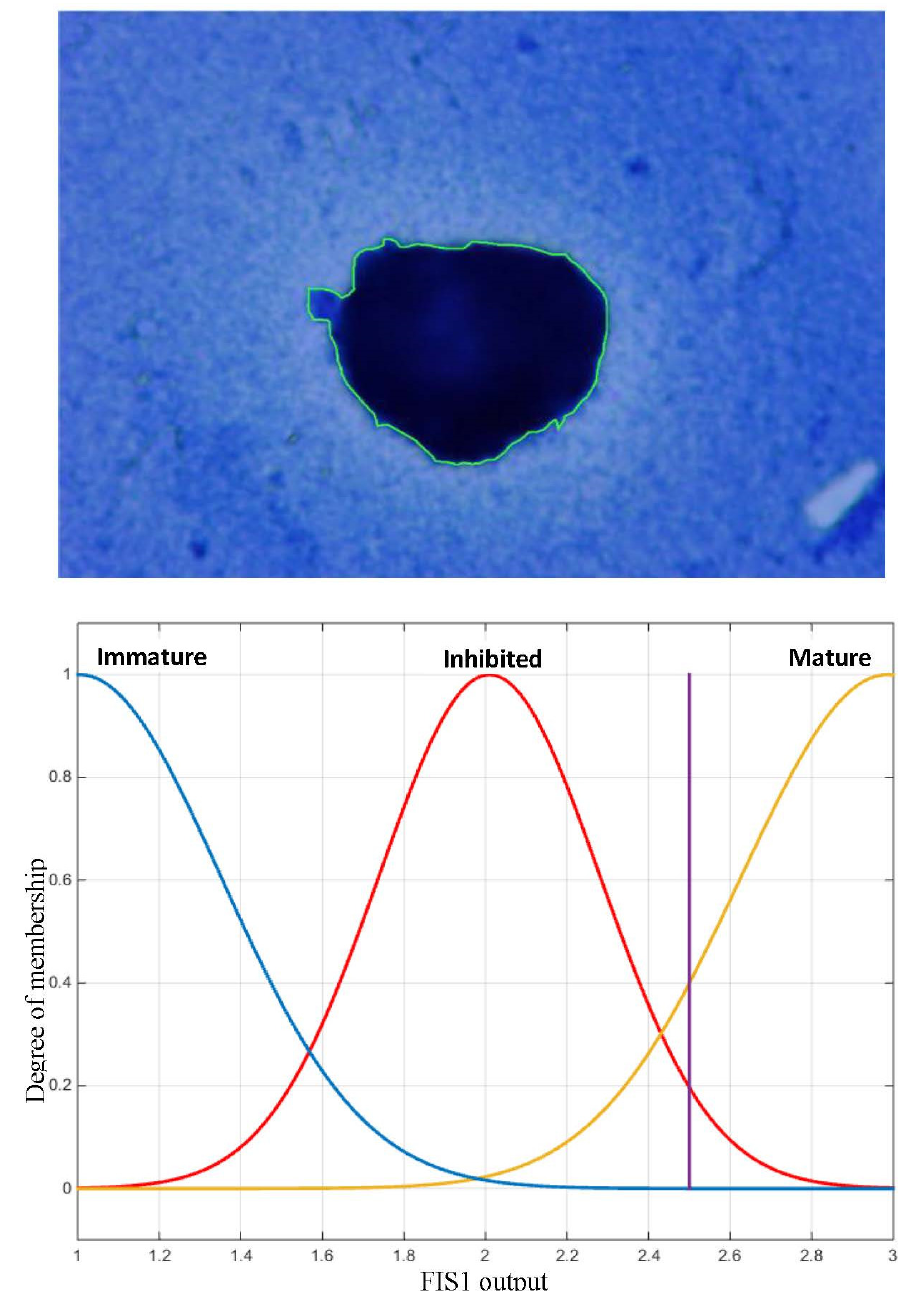
Figure 10. Membership functions of fuzzy sets of the FIS1 output. The vertical line corresponds to the defuzzification of the input corresponding to the cell. According to this curve, this cell is 20% inhibited and 40% mature.